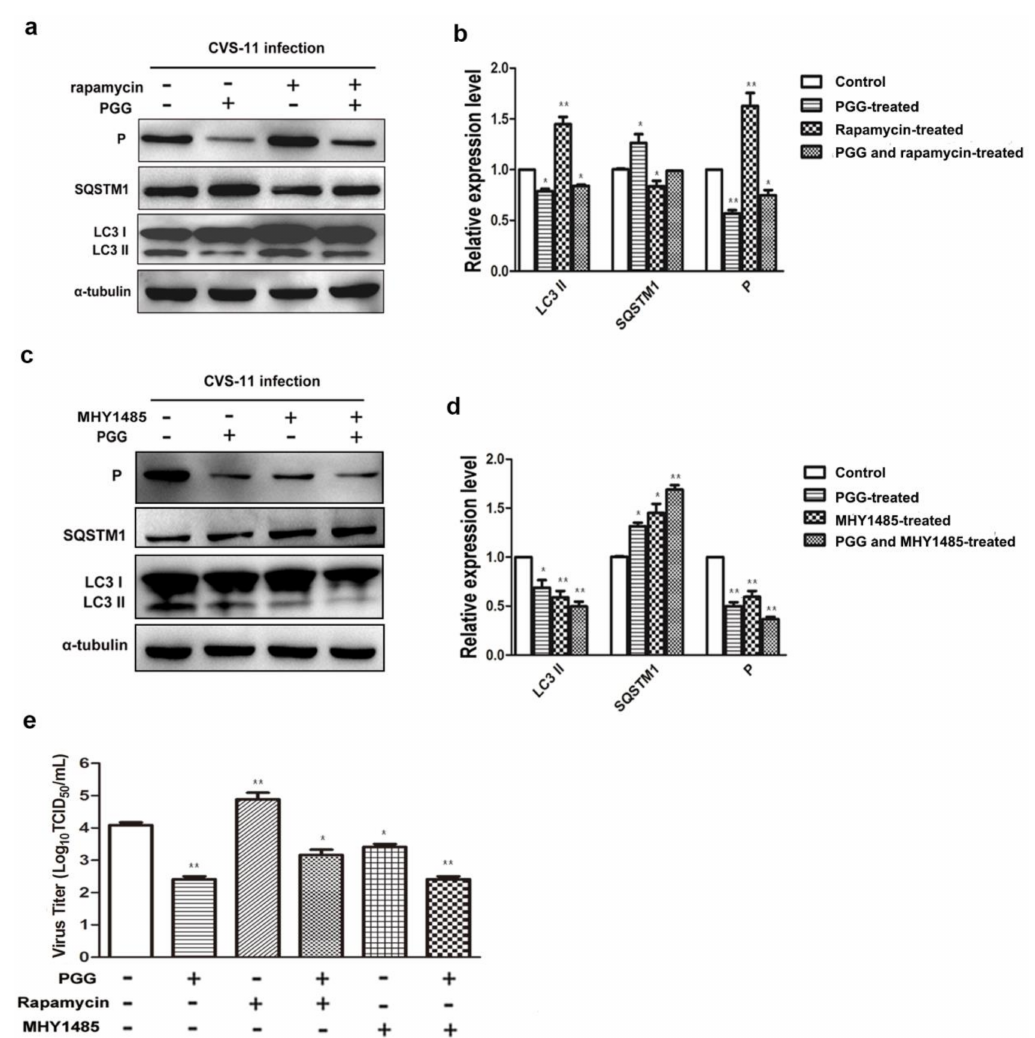
Figure 7. PGG inhibits the replication of RABV via suppression of mTOR-dependent autophagy. BHK-21 cells were pretreated with rapamycin (1 µ M) or MHY1485 (5 µ M) for 1 h, then infected with CVS-11 and PGG, rapamycin or MHY1485 respectively or in combination for 24 h. ( a , c ) autophagy markers and P protein were analyzed by Western blotting. ( b , d ) The relative expression levels of SQSTM1, LC3 and viral P, normalizing to that of α -tubulin. ( e ) The virus titers of culture supernatants were determined by TCID 50 assay and plotted. (* p < 0.05; ** p <